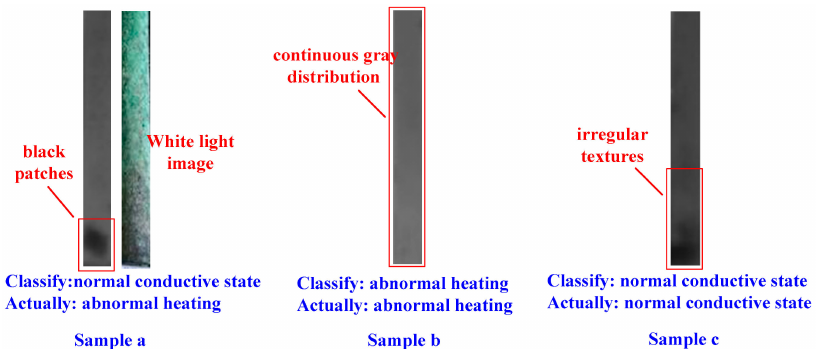
Figure 17. The comparison chart of the misclassified sample ( a ) and other samples ( b , c ) with the correct